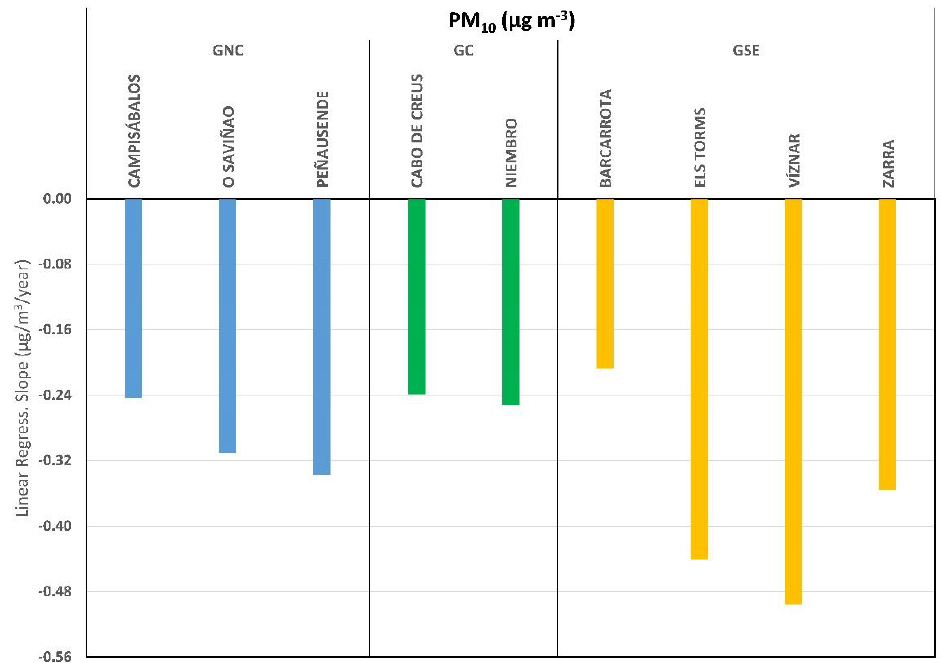
Figure 4. Annual trends by clustering group and station for the study period 2001 – 2019.